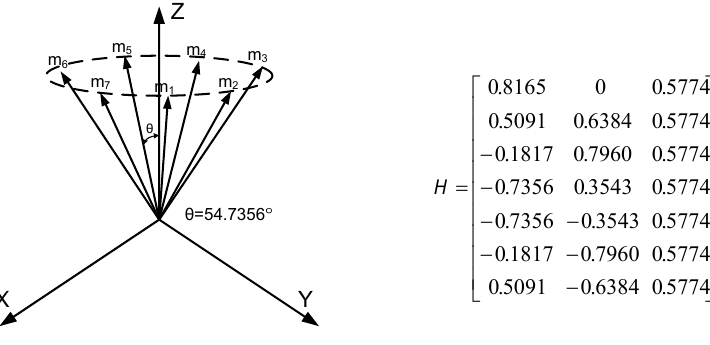
Figure 2. Configuration 1 of seven inertial sensors.